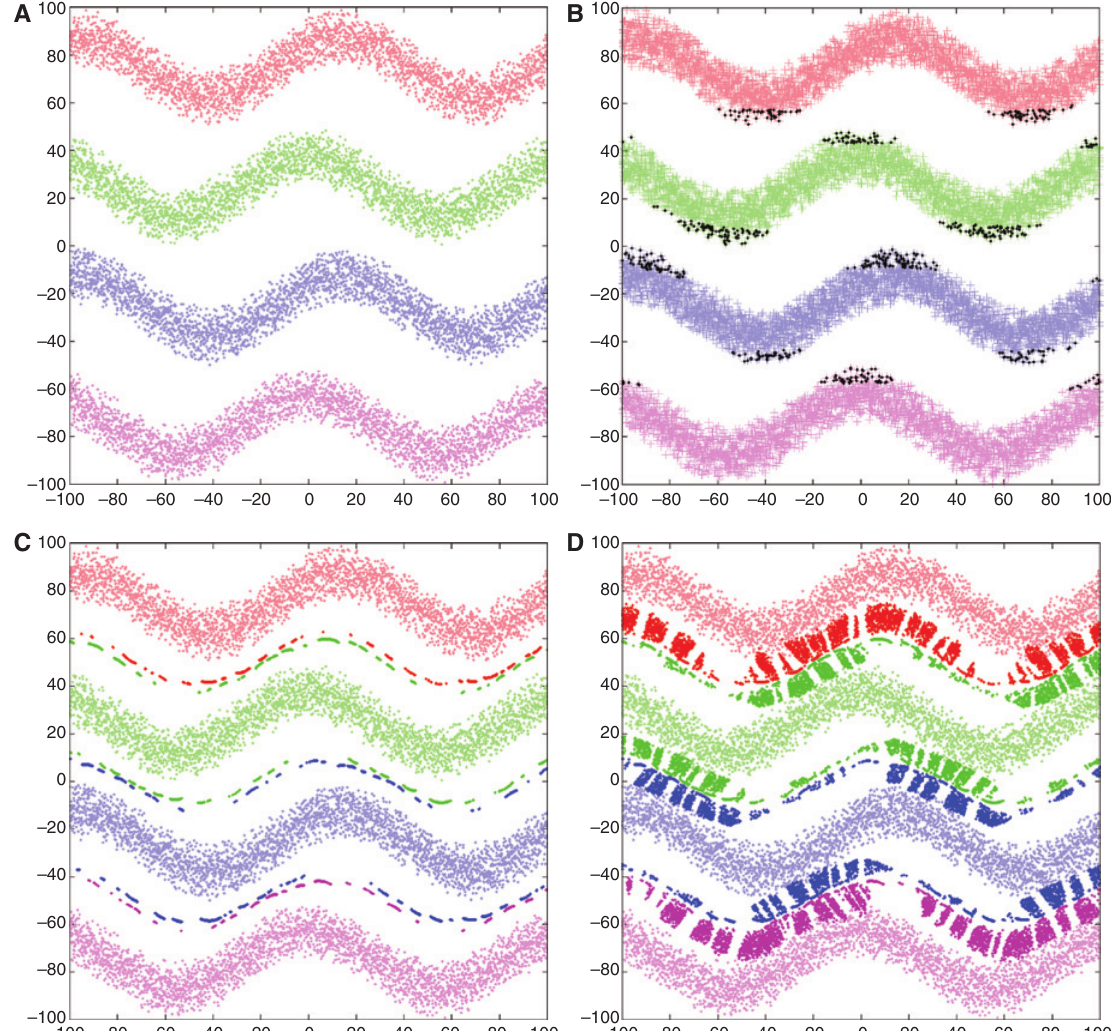
Figure 1: (A) A Four-Class Synthetic Data Set Having 3200 Samples per Class (Light Color Points). (B) A Four-Class Synthetic Data Set Having 3200 Samples per Class and Support Vectors (Black Points). (C) A Four-Class Synthetic Data Set Having 3200 Samples per Class and Synthesized Vectors (Solid-Color Points). (D) A Four-Class Synthetic Data Set Having 3200 Samples per Class and Multiclass Outpost Vectors (MCOVs) (Solid-Color Points)